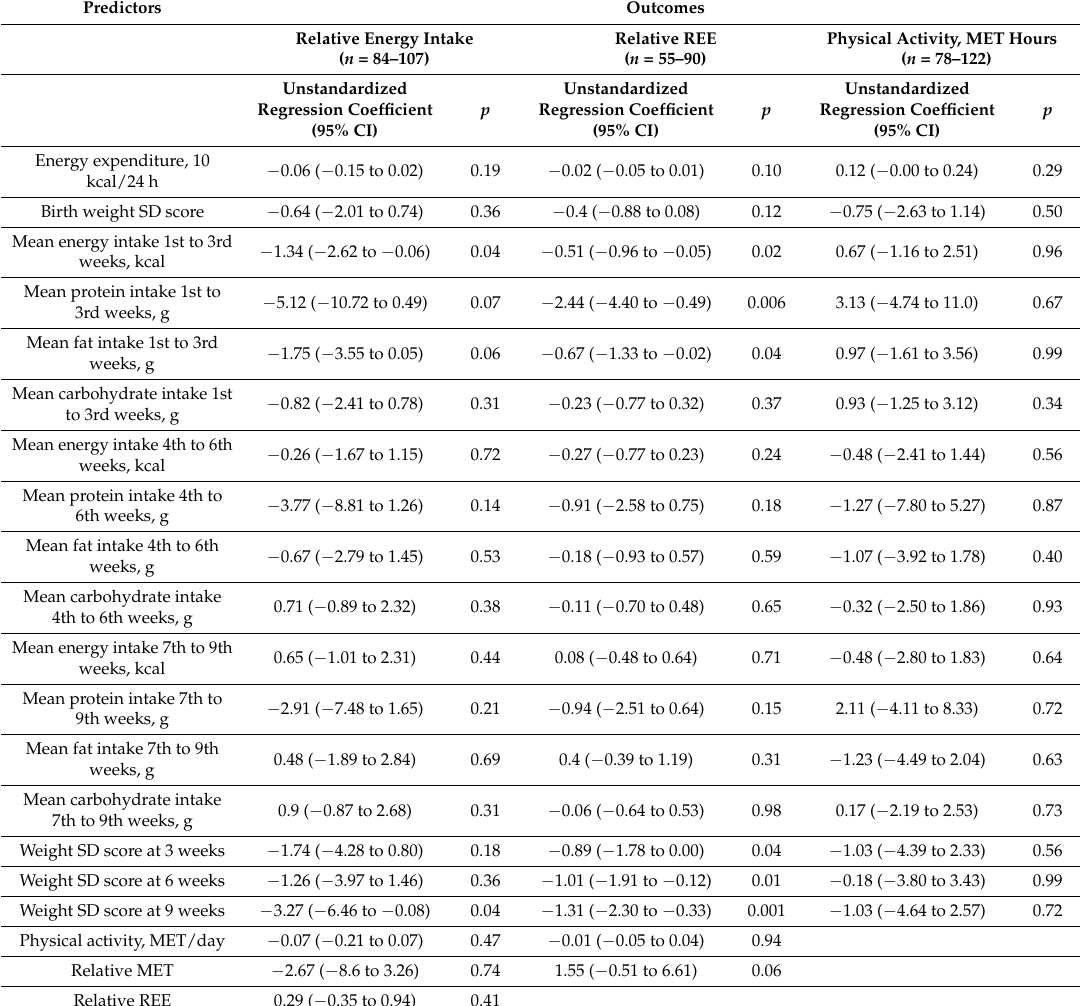
Table 2. Results from the univariate regression analysis for the complete set of predictors on the